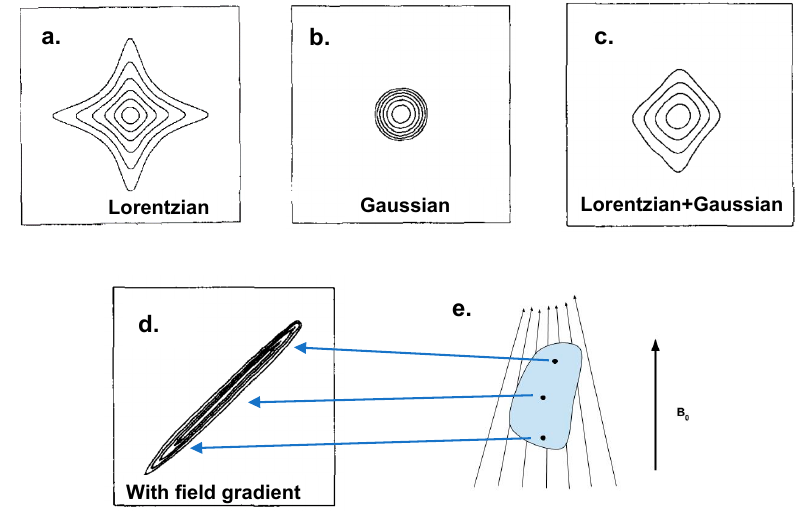
Figure 3. The line-shape of cross peaks in 2D spectroscopy in ( a ) Lorentzian, ( b ) Gaussian and ( c ) mixed shapes. The spectrum in ( a , b ) are simulated and in ( c ) is a 23 Na NOESY spectrum acquired on 2 M NaCl in D 2 O. ( d ) is acquired on the same sample as of ( c ) but with a shim gradient applied during the experiment. The schematic in ( e ) illustrates three spins located at di ff erent positions of the sample and their frequencies in the spectrum. ( a – d ) are reprinted from Ref. [50], Copyright (1995), with permission from